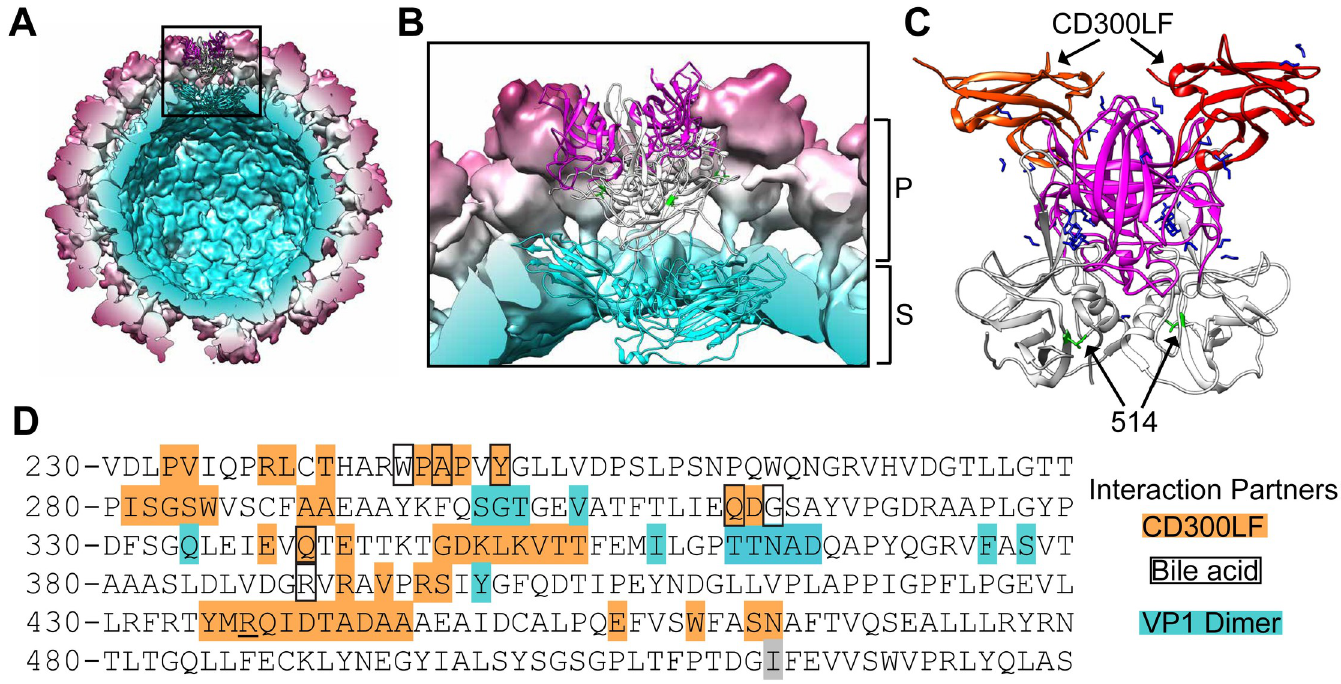
Fig 8. VP1 514 is a deeply-buried, non-surface exposed residue within the MNoV capsid. (A) A reconstruction of the CW3 capsid (PDB: 6CRJ), with the shell, P1, and P2 domains (residues 1–225; 226–277 and 416–540; 278–415, respectively, as defined previously (43)) in cyan, white, and magenta, respectively. Amino acid 514 is highlighted in green. (B) An expanded view of a single asymmetric trimer of VP1 within the CW3 capsid from the inset in (A) , colored as in (A) with the P and S domains of VP1 bracketed. (C) A 3-dimensional structure of the CW3 VP1 dimer (P1 and P2 domains only) in complex with two copies of the MNoV receptor CD300LF (PDB: 6E47). Colored as in (A) , with CD300LF additionally colored in orange/red and ligands (including bile acid glycochenodeoxycholic acid) in dark blue. (D) Amino acid sequence of CW3 VP1 residues 230–529, with known residues involved in intermolecular interactions highlighted. The grey highlight indicates residue 514, orange highlights indicate residues that interact with CD300LF, black boxes indicate residues that interact with bile acids, and cyan highlights indicate residues involved in interactions with the other copy of VP1 within the dimer. Adapted from (43). All images created using UCSF Chimera (63).